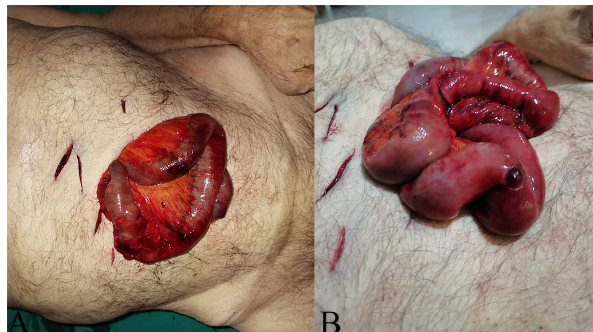
Fig. 3. Case 3. (A) Frontal view of deep and large wound and hesitation cuts. (B) Lateral view of evisceration of the intestinal